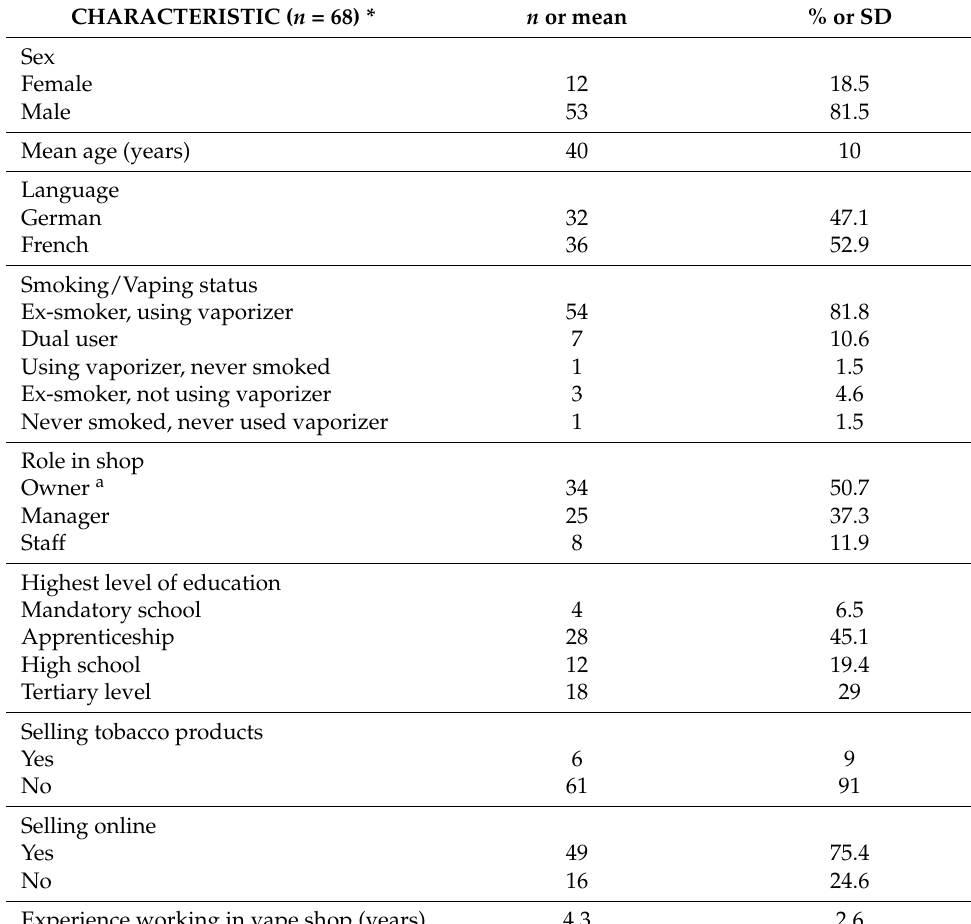
Table 1. Respondent and shop’